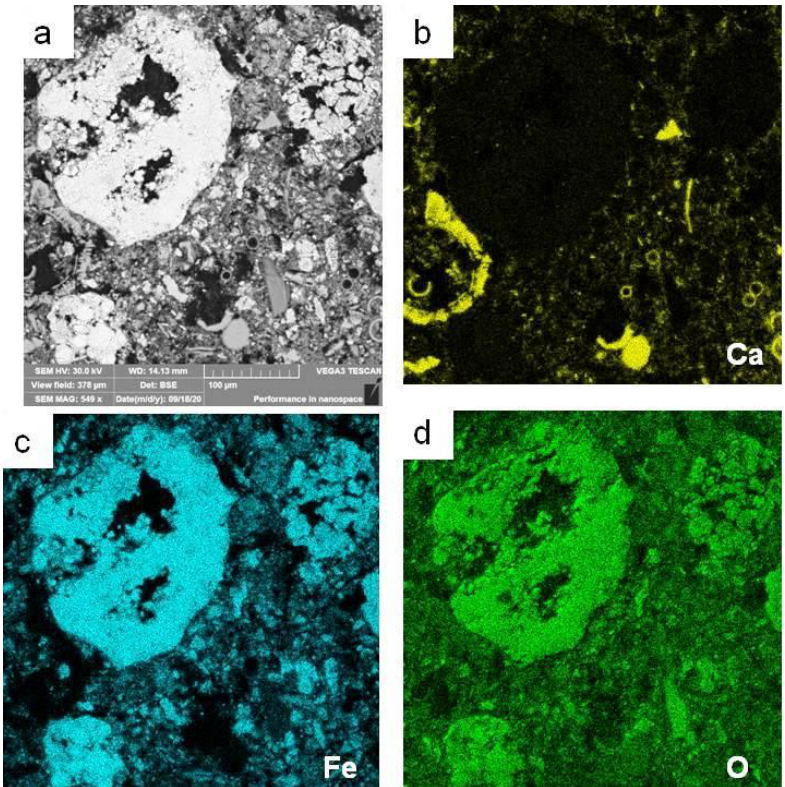
Figure 8. The SEM images of core 184k, the sediment layer of 65–70 cm; ( a ) back scattered electrons’ image; b–d, maps of the element distribution: ( b ) Са; ( c ) Fe; ( d ) O.